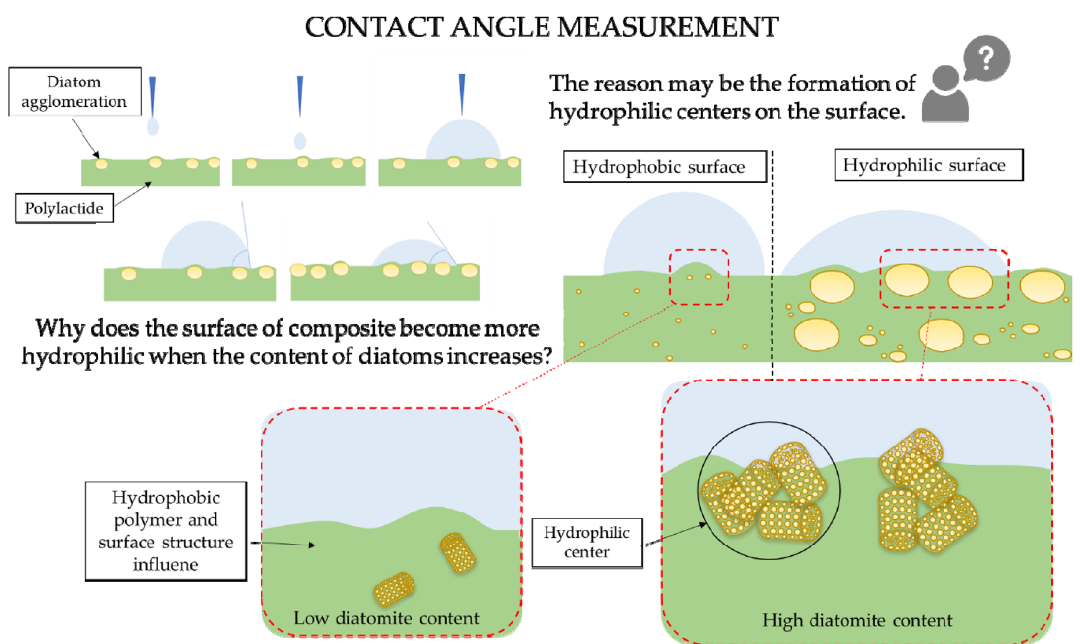
Figure 12. Loading-dependent hydrophilic-hydrophobic nature of PLA/diatomite composites’ surface.